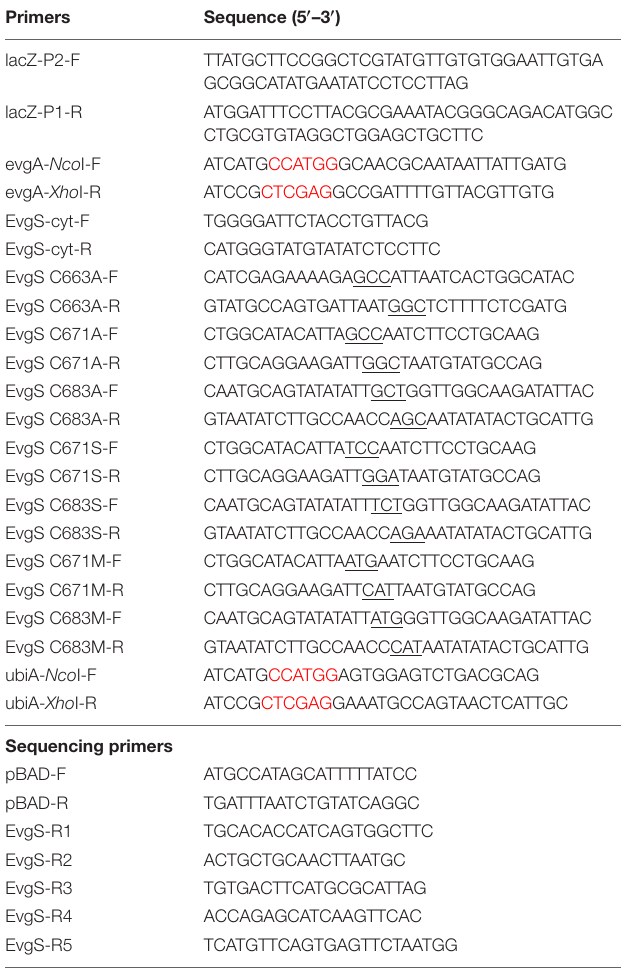
TABLE 2 | Primers used in this